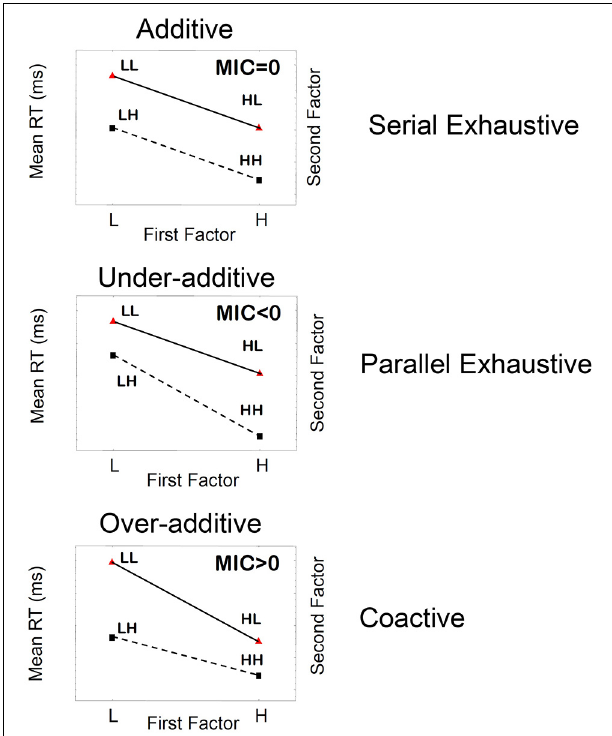
FIGURE 2 | Schematic illustration of three main patterns of mean RTs, mean interaction contrasts (MICs), and the corresponding underlying cognitive processes when the stopping rule is fixed to be